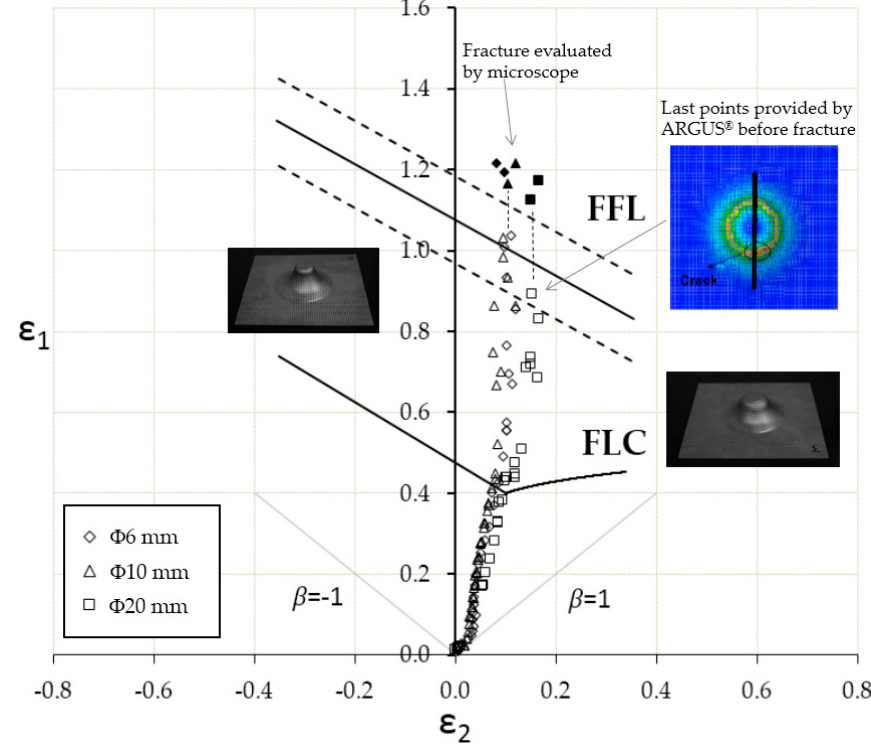
Figure 7. Principal strain state of the final testing part deformed by SPIF using tool diameters of Ф 20, Ф 10 and Ф 6 mm represented within the FLD of the material.